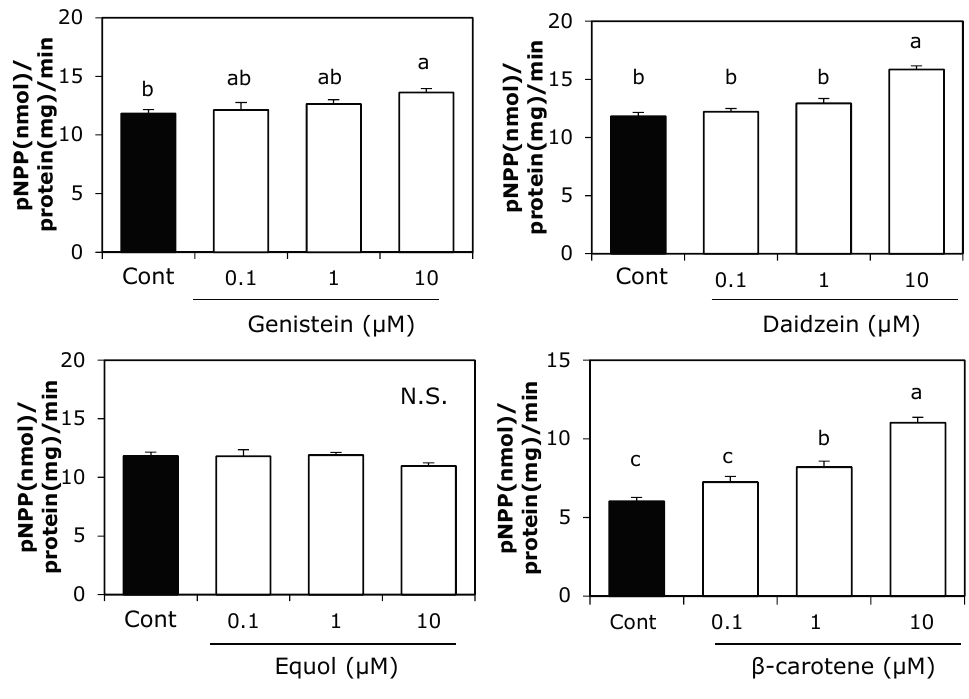
Figure 1. Effect of individual treatment with soy isoflavones or β -carotene on ALP activity in preosteoblast MC3T3-E1 cells. Cells were precultured in α -MEM/10% FBS for 24 h and subsequently cultured in medium with 10% charcoal-treated FBS containing 0.1–10 μ M of each of the soy isoflavones or β -carotene for nine days. Data are expressed as means ± SEM ( n = 4). Different letters indicate significant differences ( p < 0.05). N.S.: not significant.